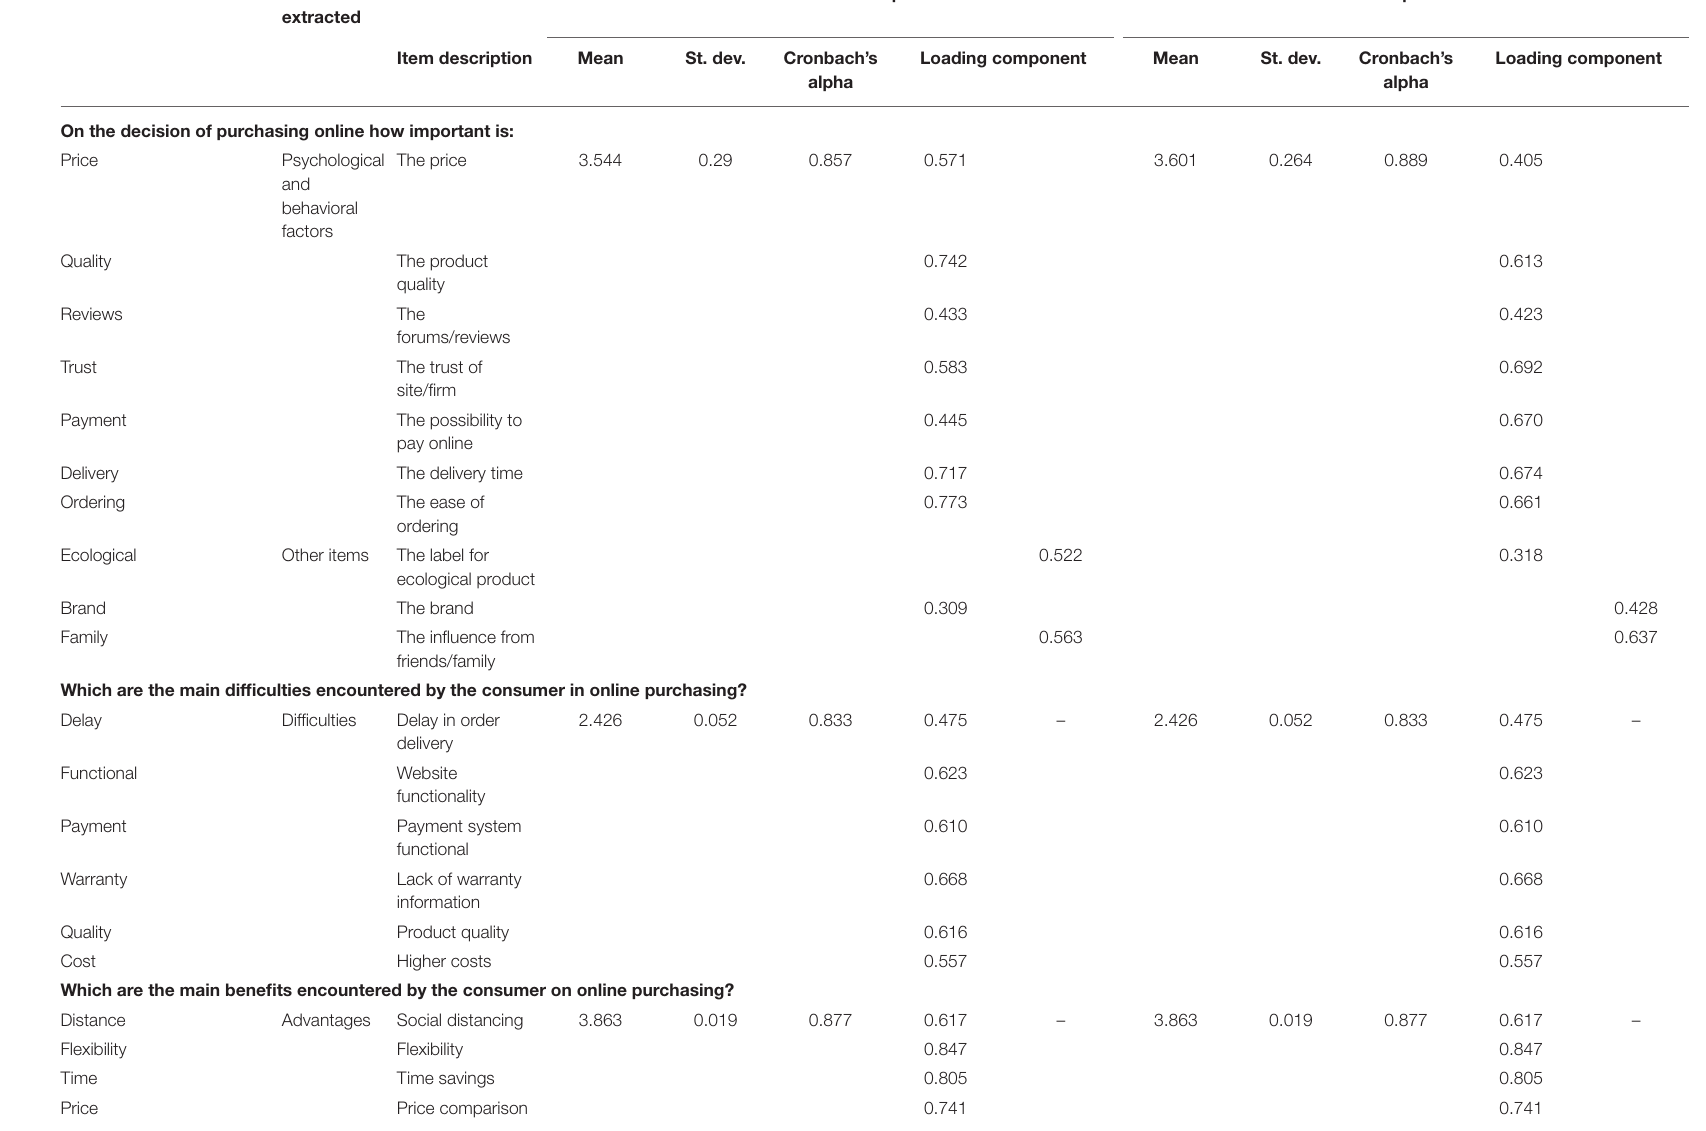
TABLE 6 | Reliability